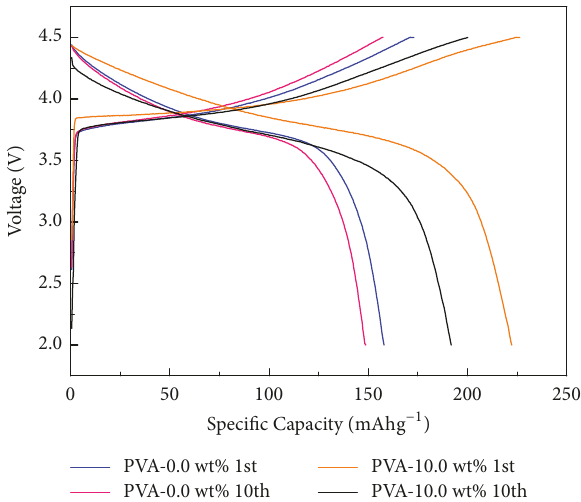
Figure 6: Cathodic EIS spectra of Li 1.25 Ni 0.2 Co 0.333 Fe 0.133 Mn 0.333 O 2 ( x = 0.0 and 10.0 wt%) materials. The inset shows the cathodic EIS spectra in the low-z’